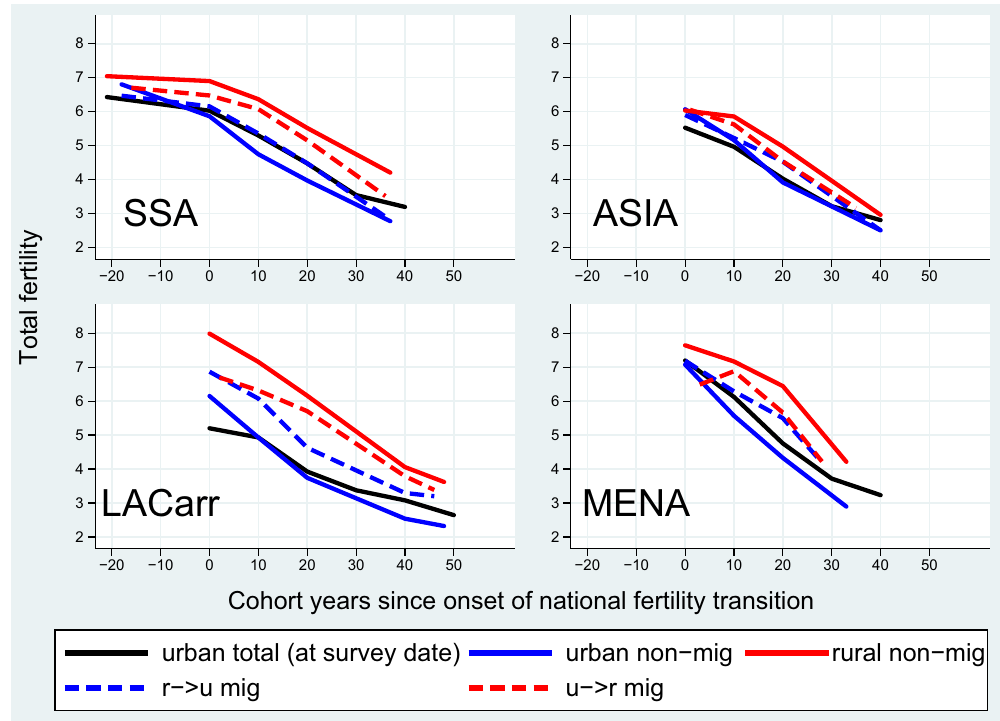
Fig 5. Regional average trend in cohort fertility among migrant and non-migrant women in urban and rural areas over the course of the national fertility transitions (onset = year 0), cohorts 1925–1978 in 55 African, Asian and Latin American countries. Source: WFS & DHS with information on migration and urban/rural status of the previous place of residence. Notes: LACarr = Latin America and the Caribbean, MENA = Middle East and Northern Africa, SSA = sub- Saharan Africa; the onset of the transition corresponds to the calendar year in which the national-level TFR peaked, which was then back-translated by the mean age at birth to get a cohort